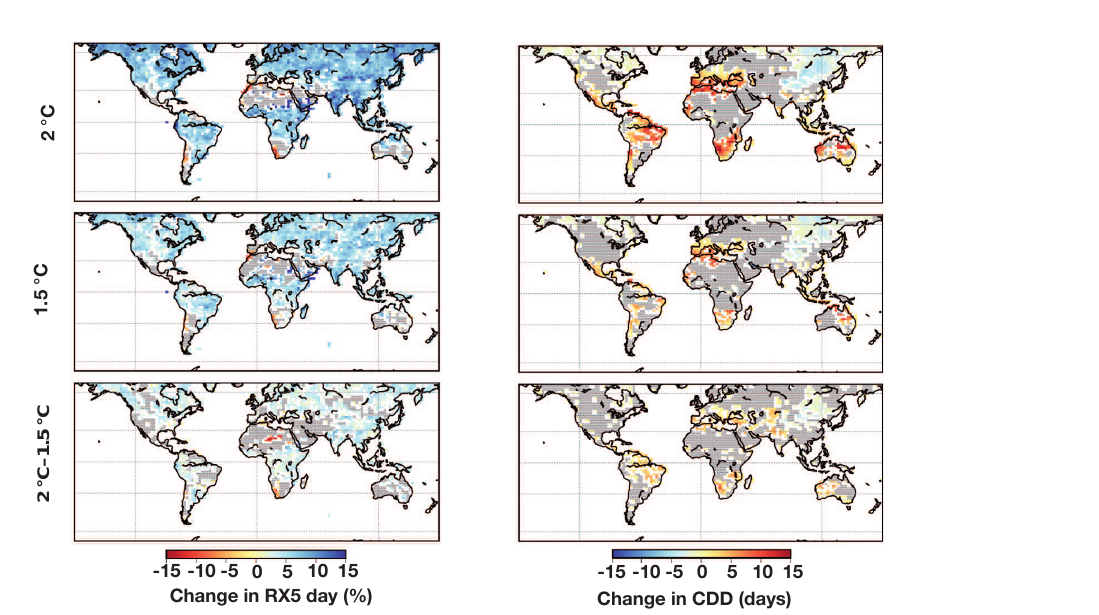
Figure 3. Same as Fig. 2, but for WSDI in days.